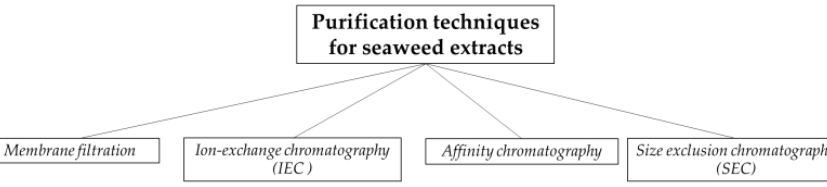
Figure 7. Examples of the most common purification techniques for seaweed